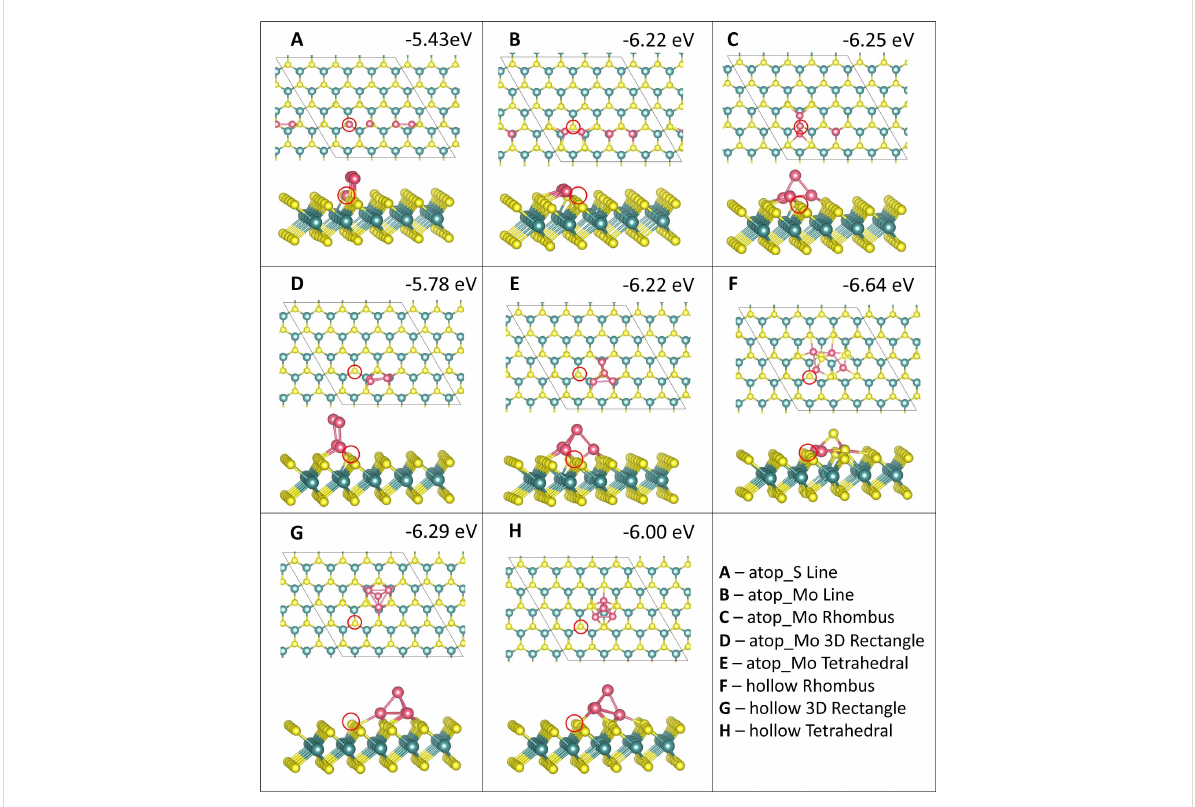
Figure 10: Atomic structure and energies of Co 4 adsorption modes on defective MoS 2 . The red circle indicates the location of the S vacancy.